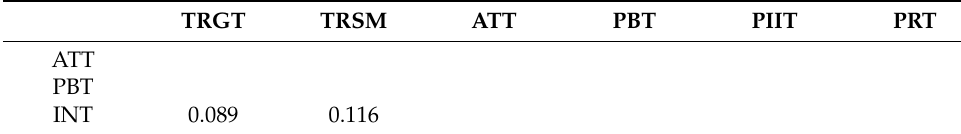
Table 6. Indirect effect in the structural model.